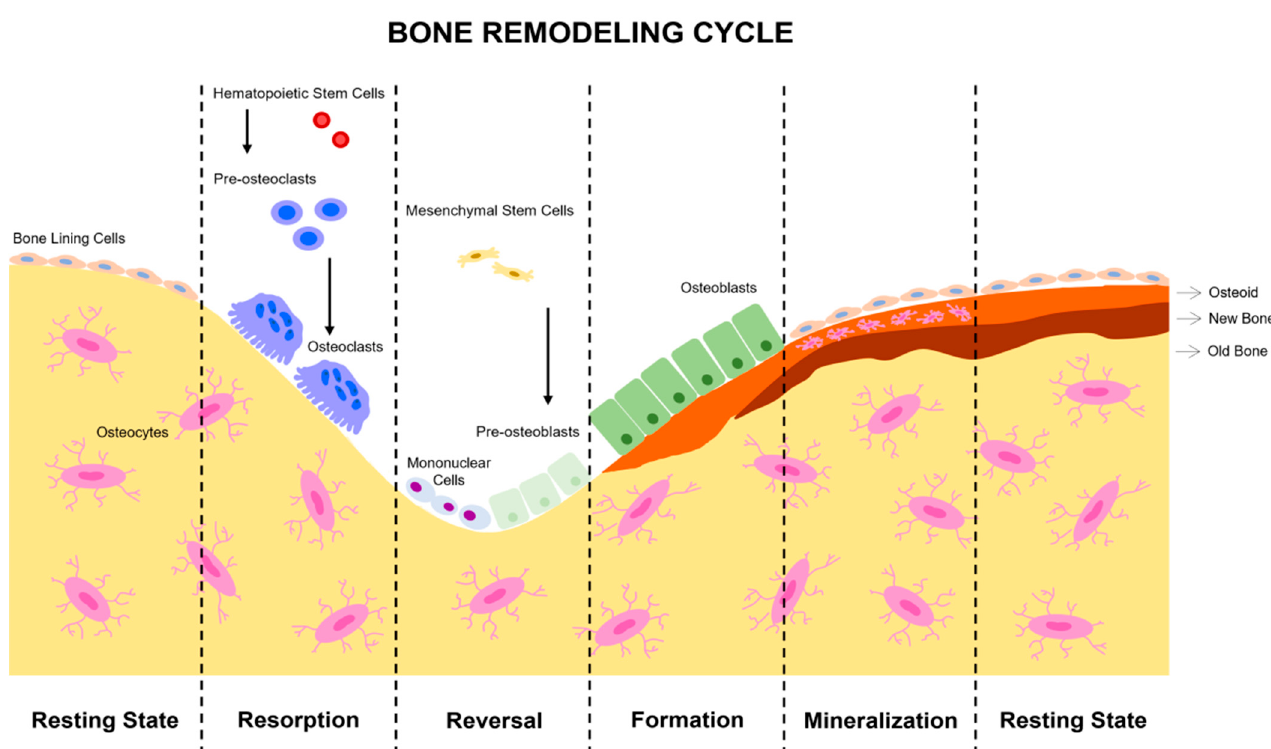
Figure 1. Stages of bone remodeling. In a balanced system, bone remodeling begins with bone resorption and ends with osteoblast formation. The complete cycle is composed of the phases of activation, resorption, reversion, formation and, finally, mineralization. Initially, a signal is detected which activates resorption by attracting osteoclast precursors to the area to be remodeled. This phase is of limited duration and depends on the degree of stimuli received, causing osteoclast differentiation and activity. Then, in the reversion phase, almost all of the osteoclasts disappear, and osteoblast precursors of mesenchymal origin begin to form. In the formation phase, all the osteoclasts are definitively replaced by osteoblasts. Finally, the mineralization of new bone tissue occurs. The new tissue remains at rest until the next cycle of remodeling.